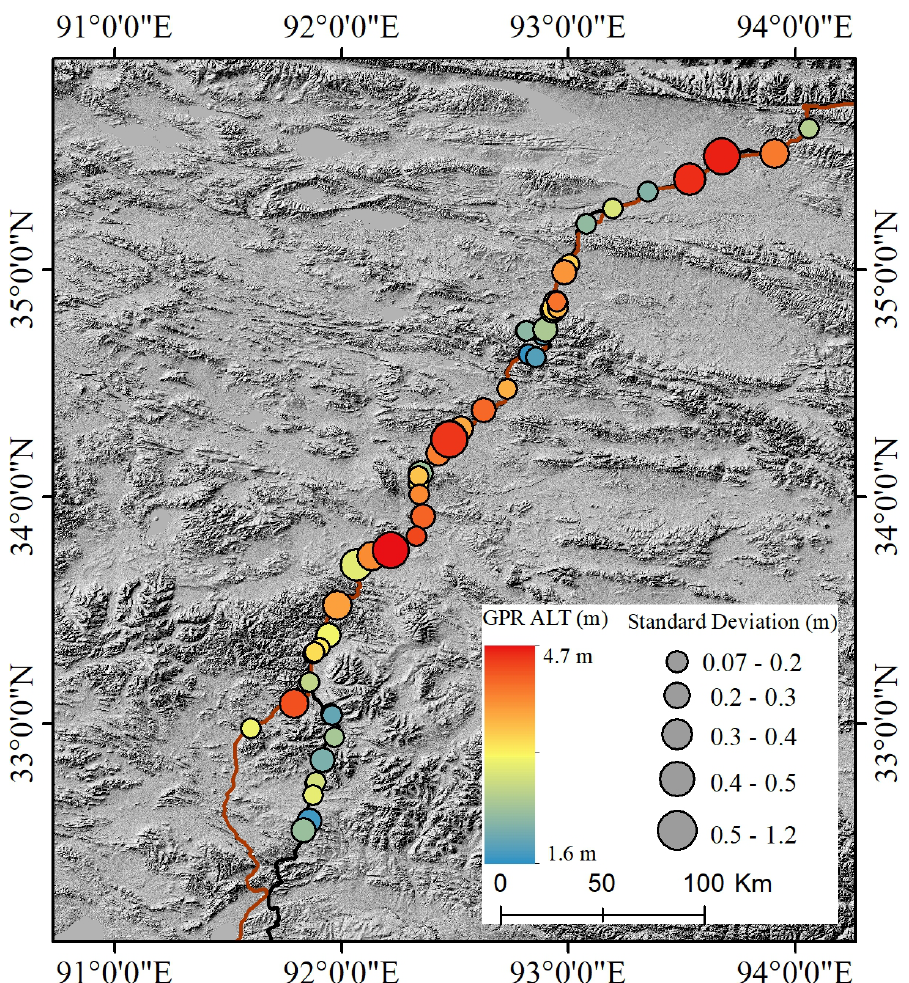
Figure 7. Spatial distribution of active layer thickness (ALT) of each ground-penetrating radar (GPR) section along the Qinghai–Tibet Engineering Corridor. The aggregated mean ALT of each GPR section is shown with the standard deviation (point size).